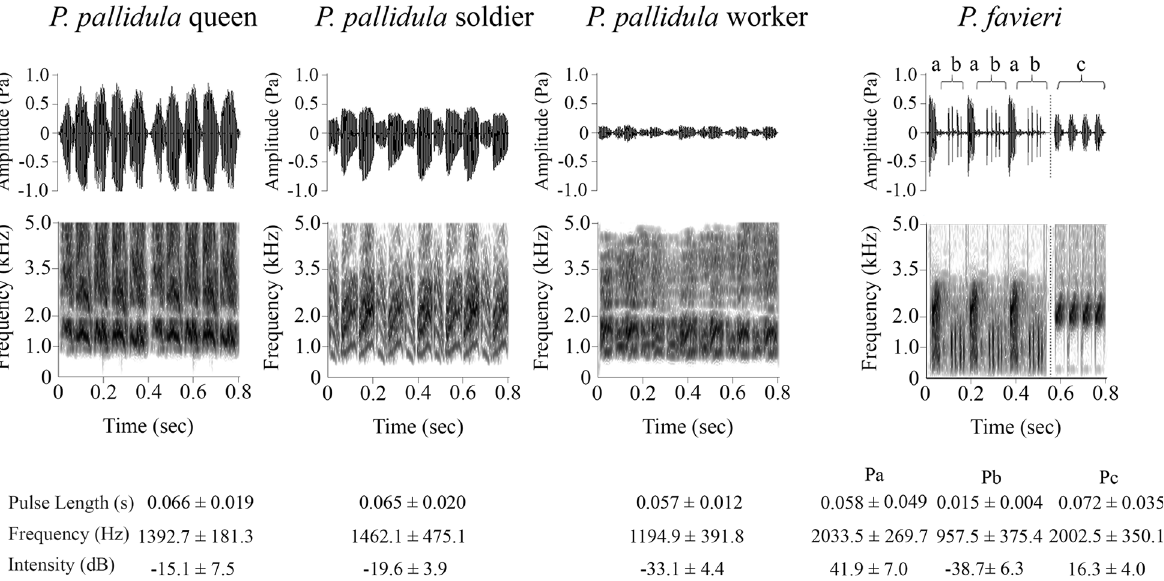
Fig 2. Waveforms and spectrograms of stridulations emitted by Pheidole pallidula castes and Paussus favieri . Waveforms of stridulations emitted by three Pheidole pallidula castes (queen, soldier and worker) and by Paussus favieri (Pulses a-b-c) are shown in the upper part of the figure. Pulses a (Pa), which are more similar to the sounds emitted by soldiers and workers, and Pulses b (Pb), which are similar to the sounds emitted by workers, are found alternating in trains. Pulses c (Pc) are closer to queens ’ stridulations and are emitted subsequently, to form different trains. The lower part of the figure shows the corresponding spectrograms: darker parts correspond to higher energy densities while lighter parts correspond to lower energy densities.